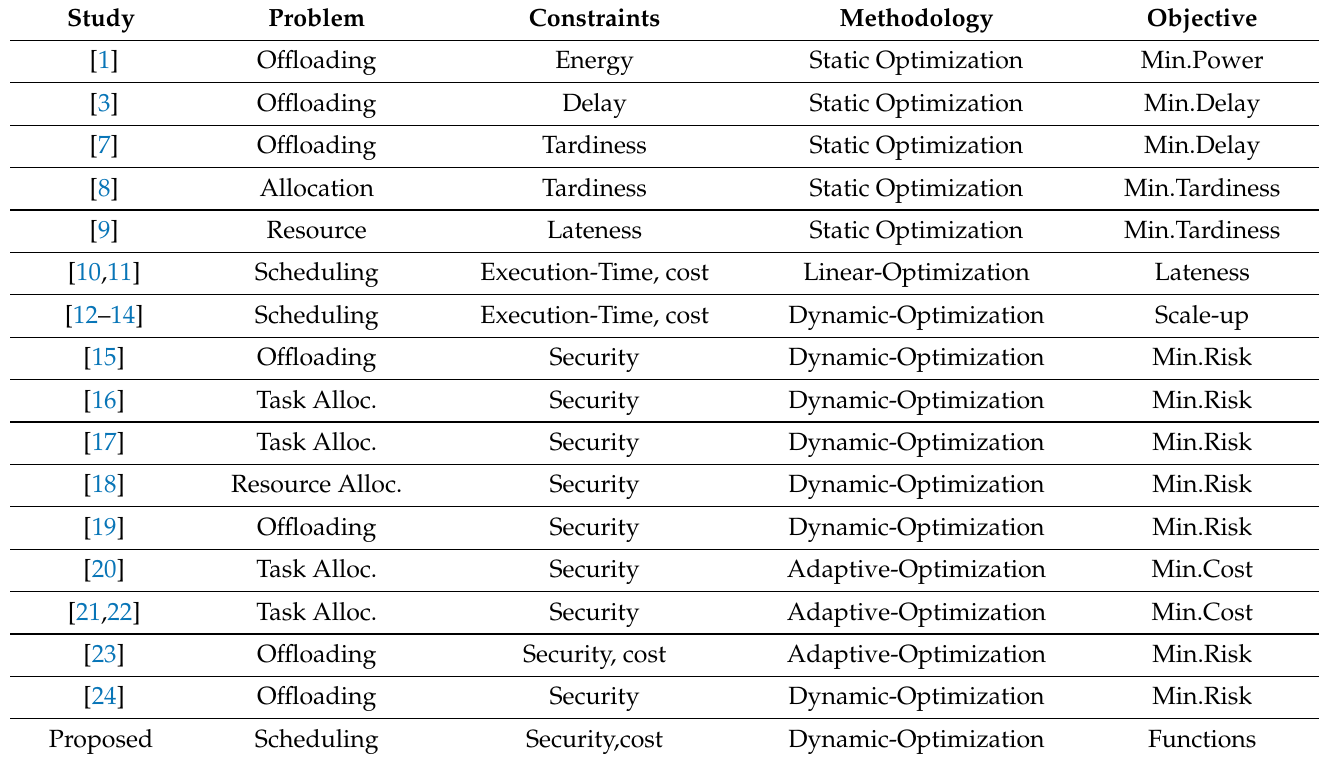
Table 1. Existing Blockchain-Enable IoMT System and